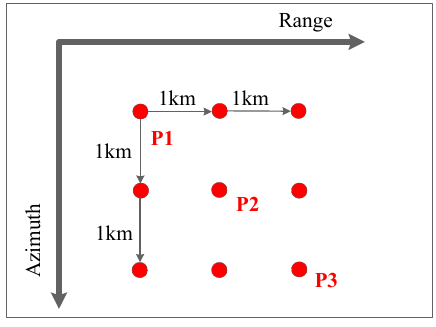
Figure 14. The designed scene with nine point-targets.